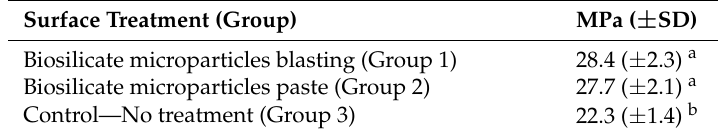
Table 2. Mean values (MPa) and standard deviations ( ± SD) of microtensile bond strength to dentin as a function of surface